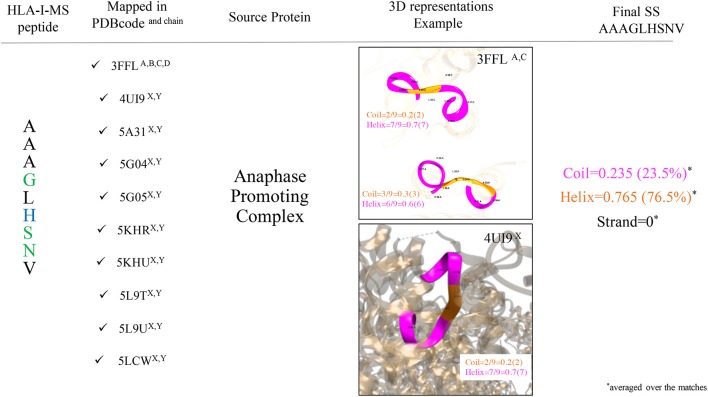
Workflow used to determine SS of the HLA-I-MS-PDB peptides, taking AAAGLHSNV as an example. AAAGLHSNV is located on chains A, B, C, and D of the structure with PDBid 3FFL and on chains X and Y of the structures with PDBid 4UI9, 5A31, 5G04, 5G05, 5KHR, 5KHU, 5L9T, 5L9U, and 5LCW. Fragments are pictured in ribbon with coil residues in orange and helical residues in magenta. AAAGLHSNV exhibits 23.5% of residues in coil and 76.5% of the residues in helix and 0% of the residues in strand.